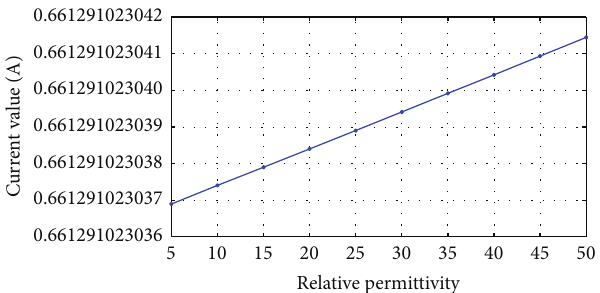
Figure 11: Curve of the maximum current value with the relative permittivity.